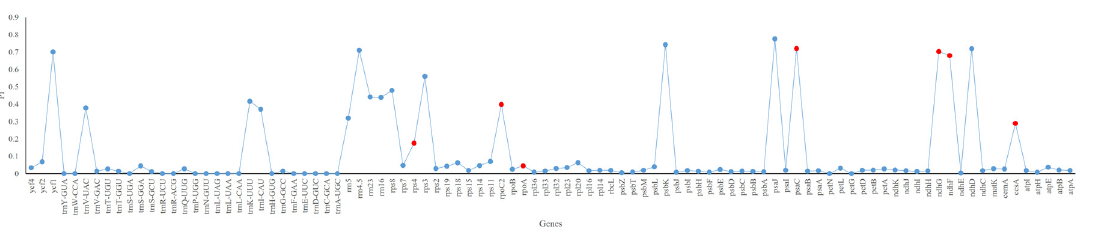
Figure 5. The nucleotide diversity (Pi) computed using 96 common genes of T. alexandrinum and T. resupinatum. Genes with Ka/Ks values more than one were red coded.